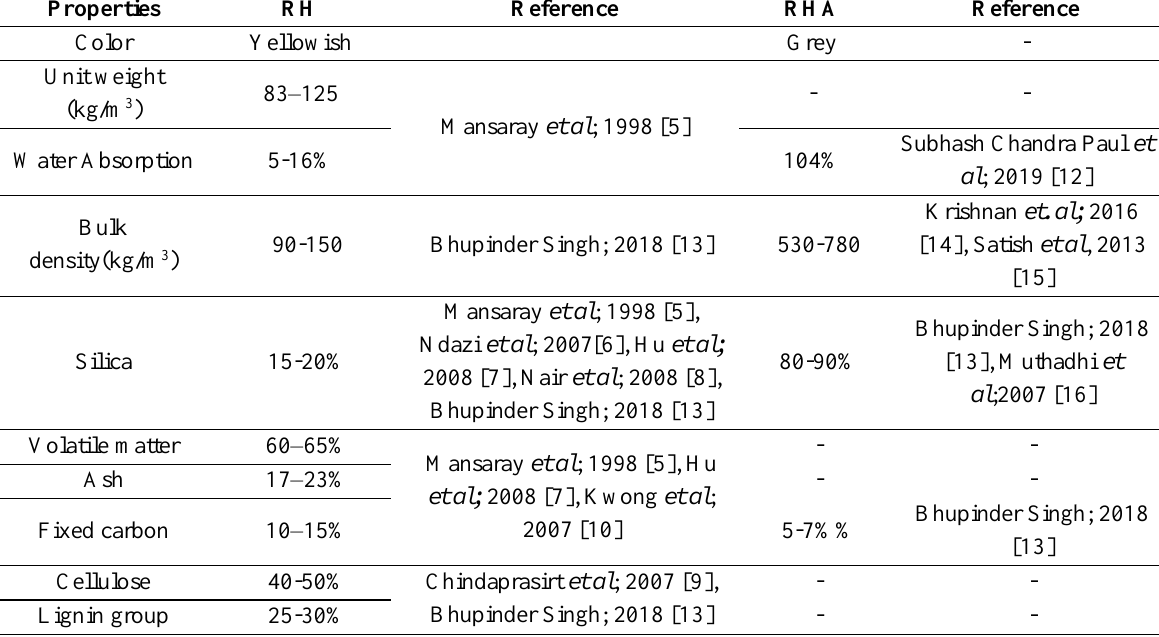
Table 2. For this research, Rice husk (Fig. 2a) is used as partial replacement of cement. Table 2 Comparison of physical and chemical properties of RH and